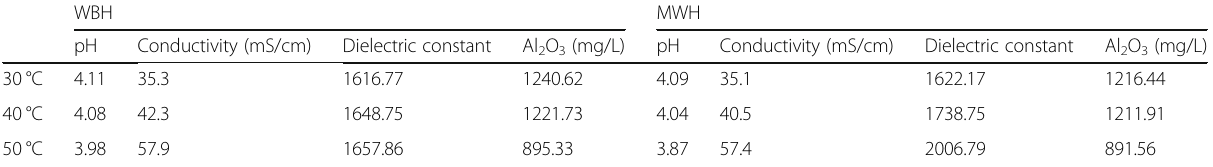
Table 1 Analysis for the tanning effluents of hide powder under different heating methods WBH MWH pH Conductivity (mS/cm)